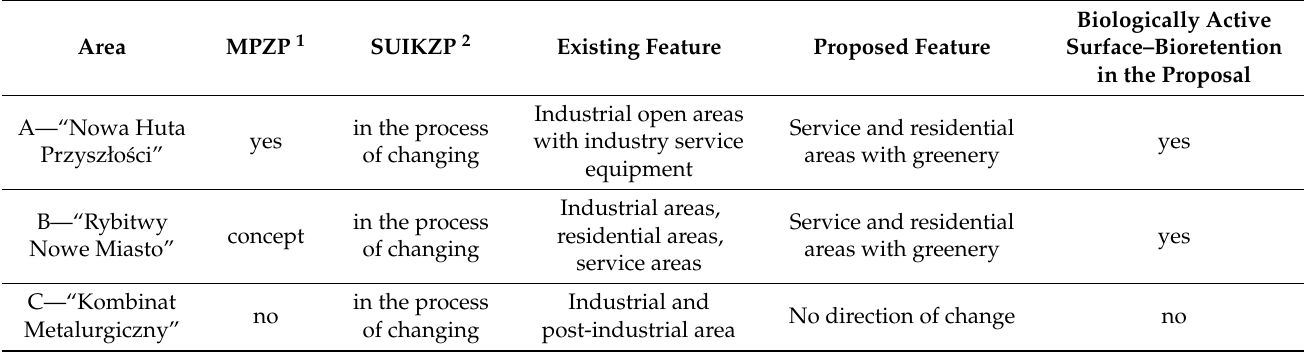
Table 6. Comparison of areas due to the current function and the function proposed in the provisions of local development plan and Study of the conditions and directions of spatial development.